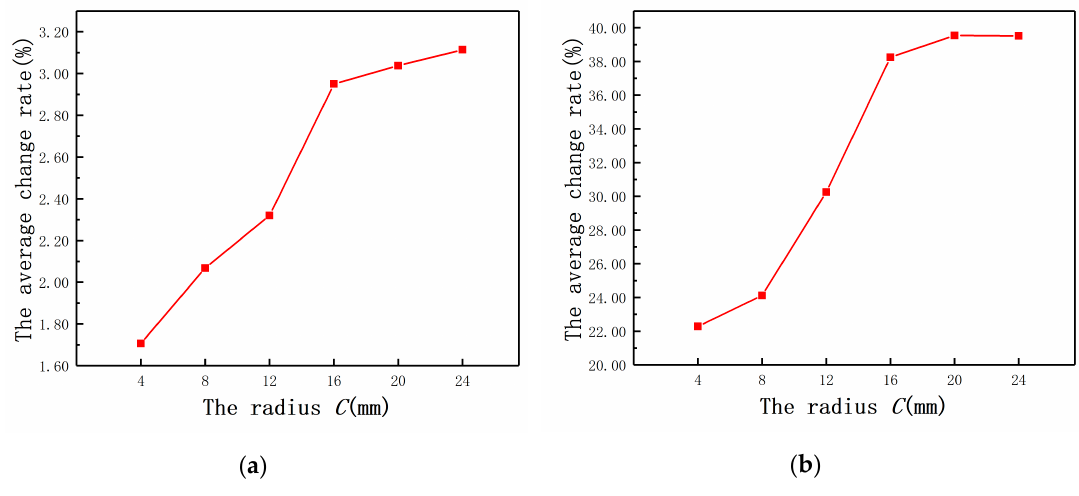
Figure 12. The average change rates under different radii: ( a ) L s ; ( b ) R s